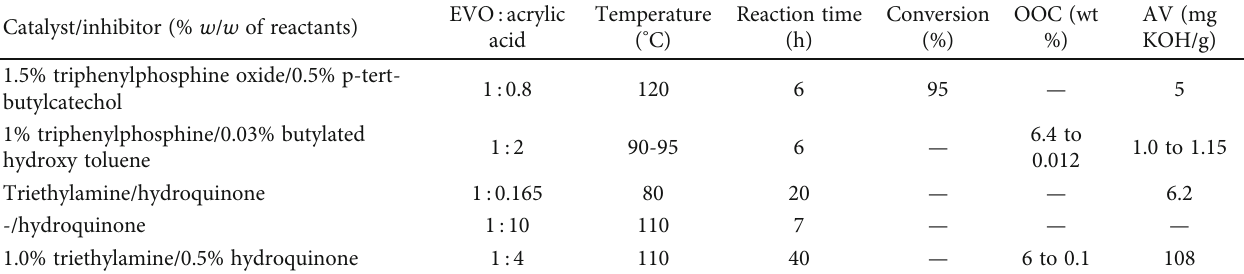
Table 3: FTIR absorption peaks of ESO and AESO [43].